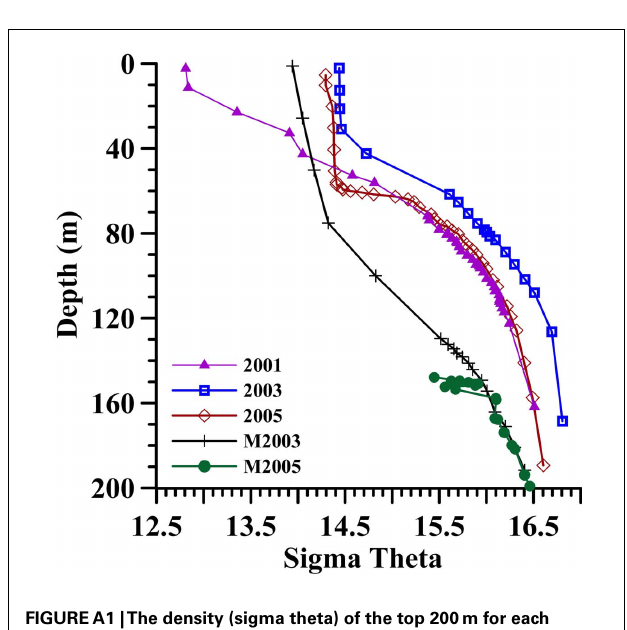
FIGUREA1 |The density (sigma theta) of the top 200m for each station discussed in this paper: theWestern Gyre in 2001 (purple triangles), 2003 (blue squares), and 2005 (red diamonds) and at the mixing zone station in 2003 (black crosses) and 2005 (green